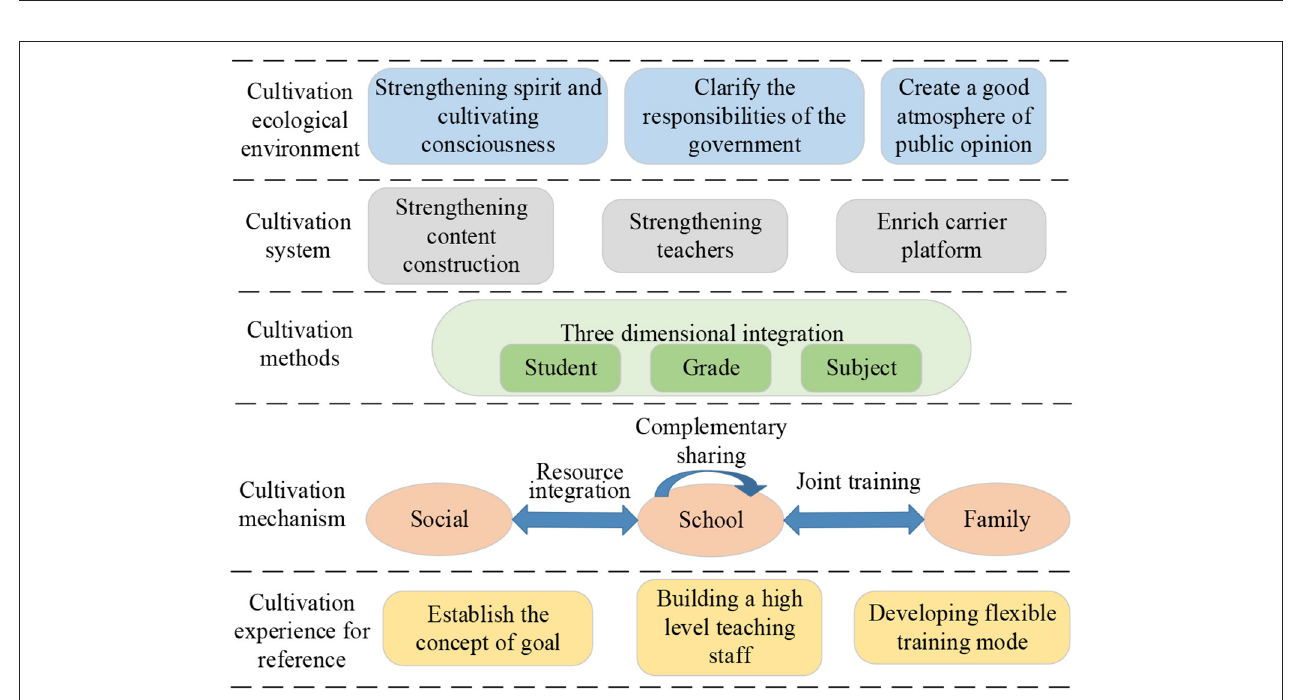
FIGURE 6 | Analysis of the development of entrepreneurial activities in universities and atmosphere analysis [ (A) . Analysis of the current situation of entrepreneurial activities in universities. a4. Unclear; b4. Else; c4. Related practice; d4. Entrepren-eurial base; e4. Related speeches; f4. Related lectures; g4. Related courses; (B) . Investigation on the degree of the entrepreneurial atmosphere in universities].